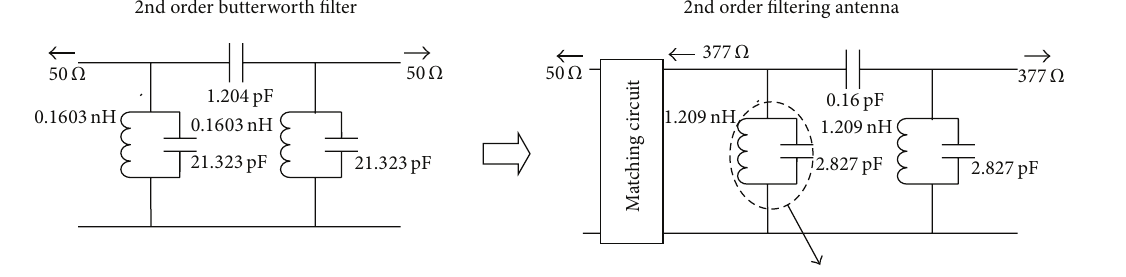
Figure 4: Schematic diagram that illustrates the solution